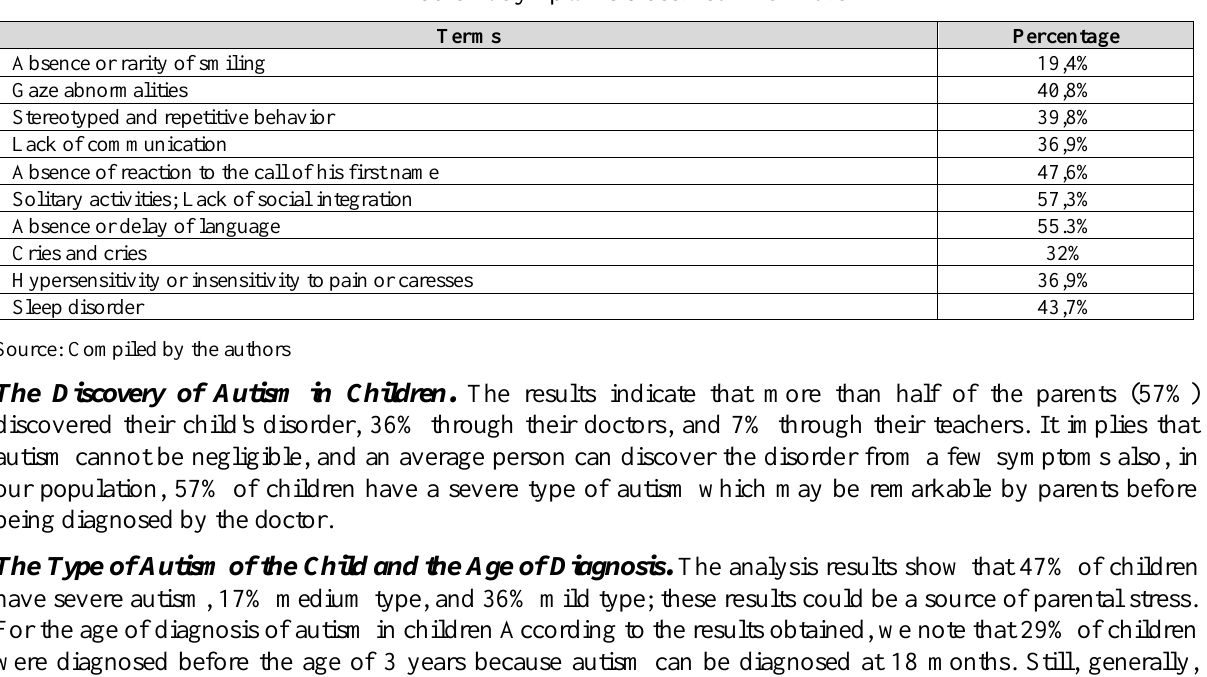
Table 2. Symptoms Observed in